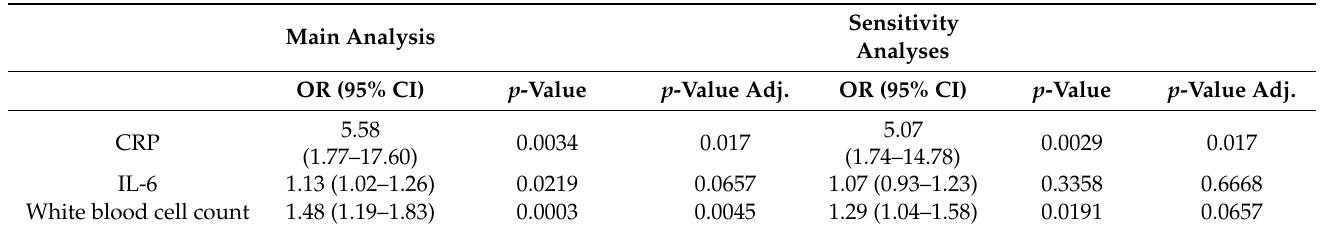
Table 3. Association between circulating inflammatory markers and elevated D-dimer concentrations. Main